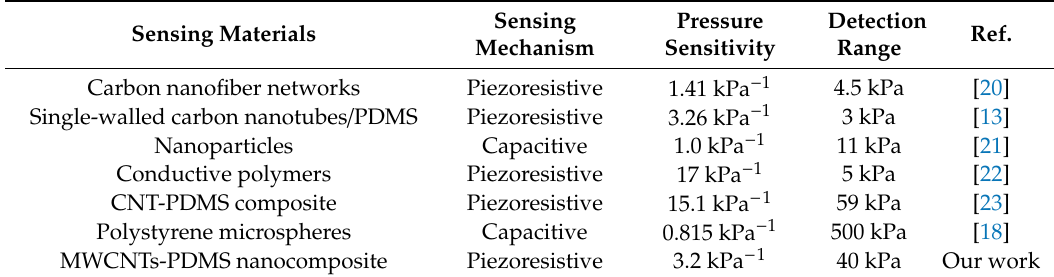
Figure 8. ( a ) Current-voltage curves of the tactile sensor under different pressures; ( b ) resistance variations of different structure layer combinations; resistance variations of different structure layer combinations in ( c ) the low pressure range and ( d ) the high pressure range. DPRS: dense pyramid structure and rough structure, SPRS: sparse pyramid structure and rough structure. Table 2. The comparison of the pressure response and sensing range between this work and the recent reported works.